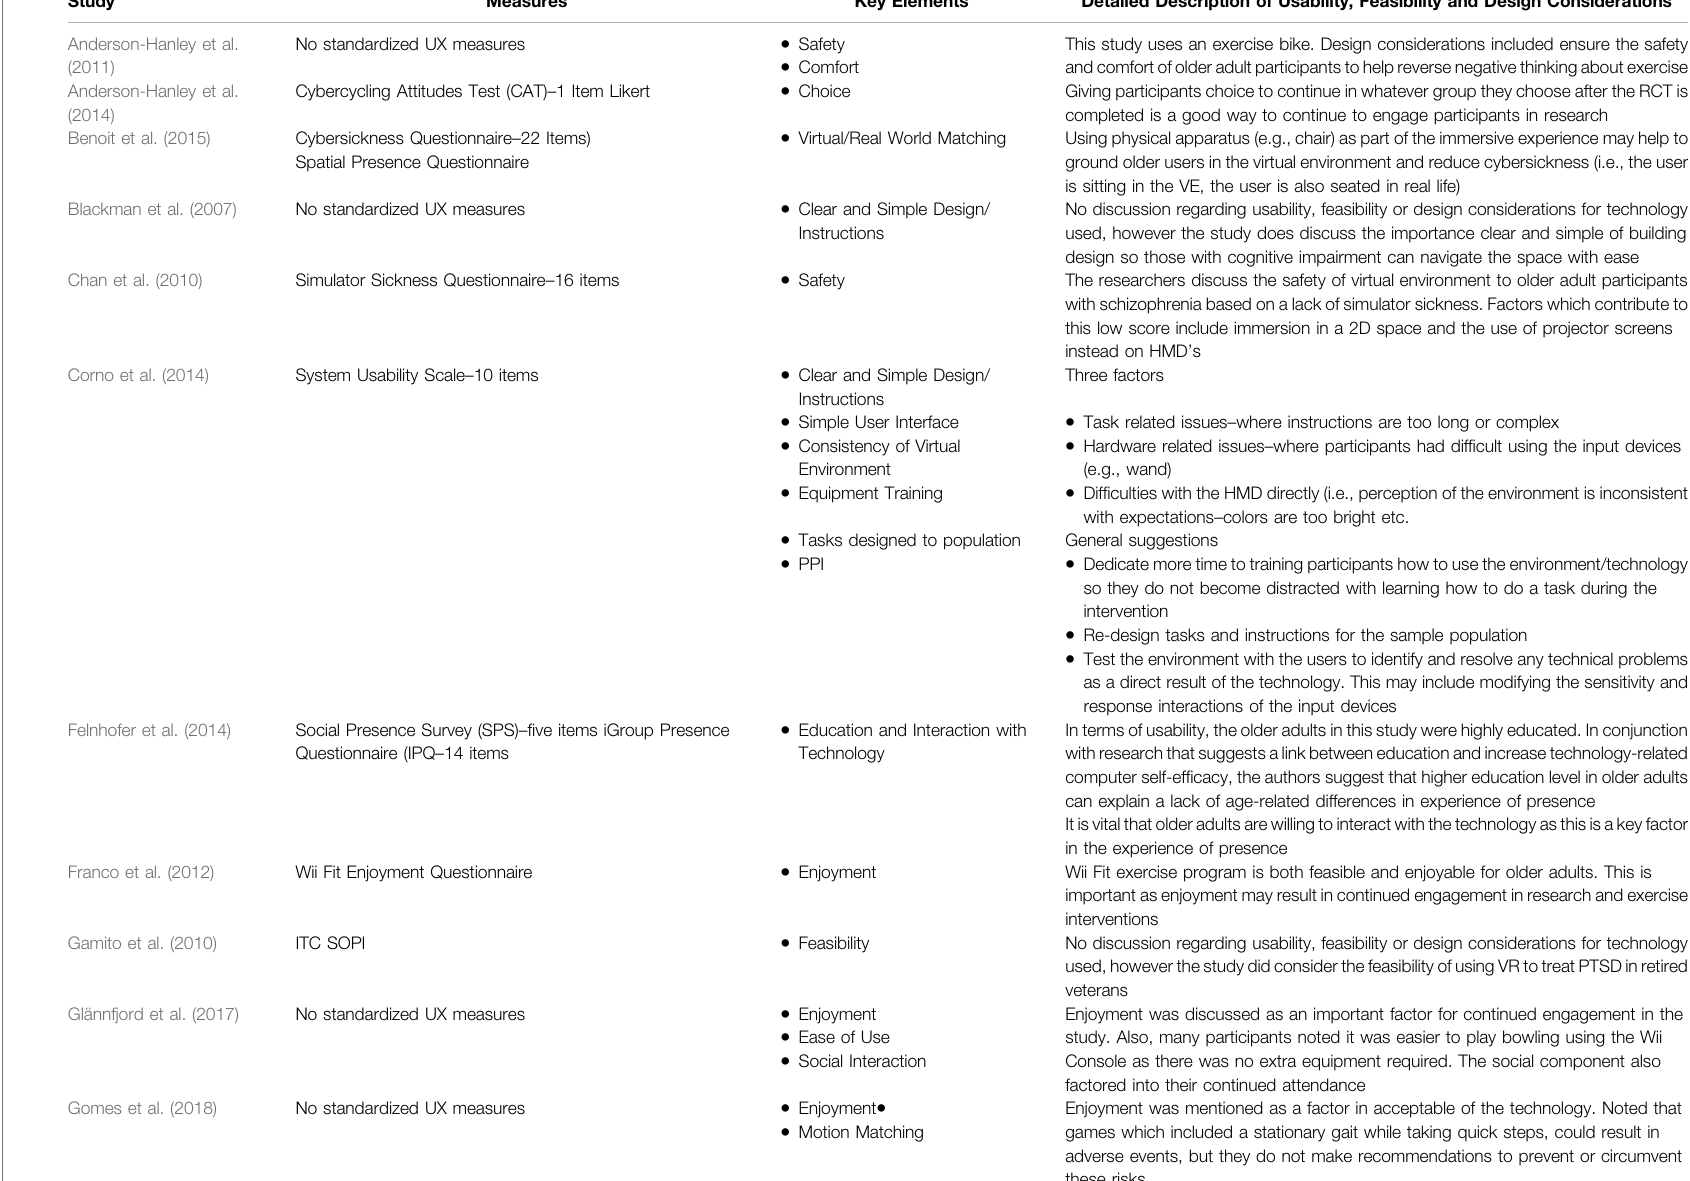
TABLE 7 | Usability, feasibility and design